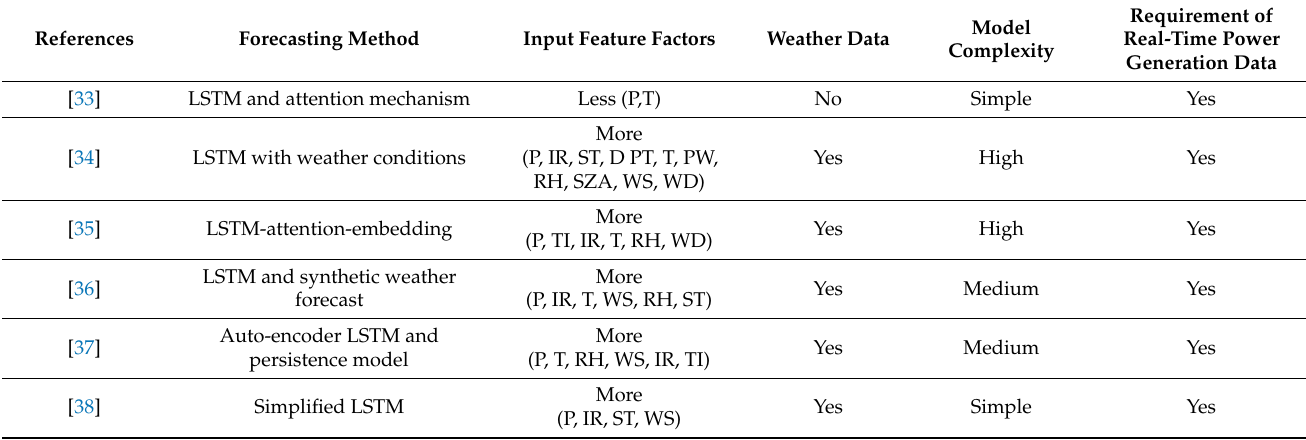
Table 2. Research comparisons of different forecasting methods in previous research